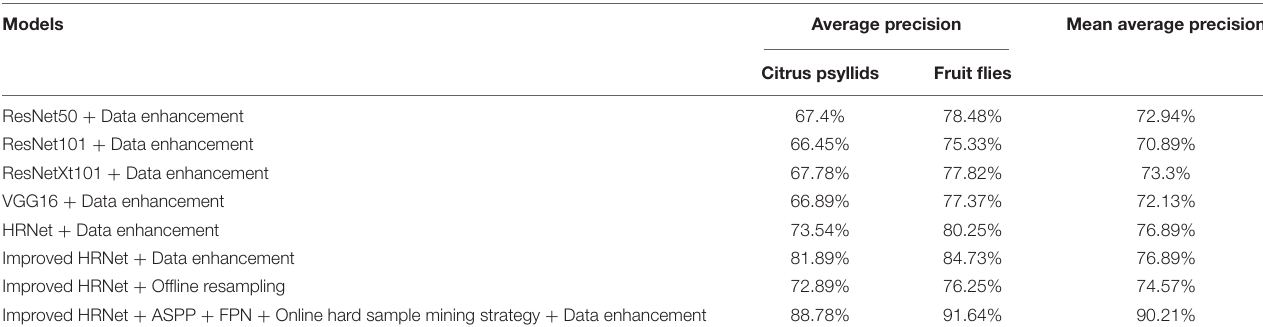
TABLE 1 | Different model recognition effects.